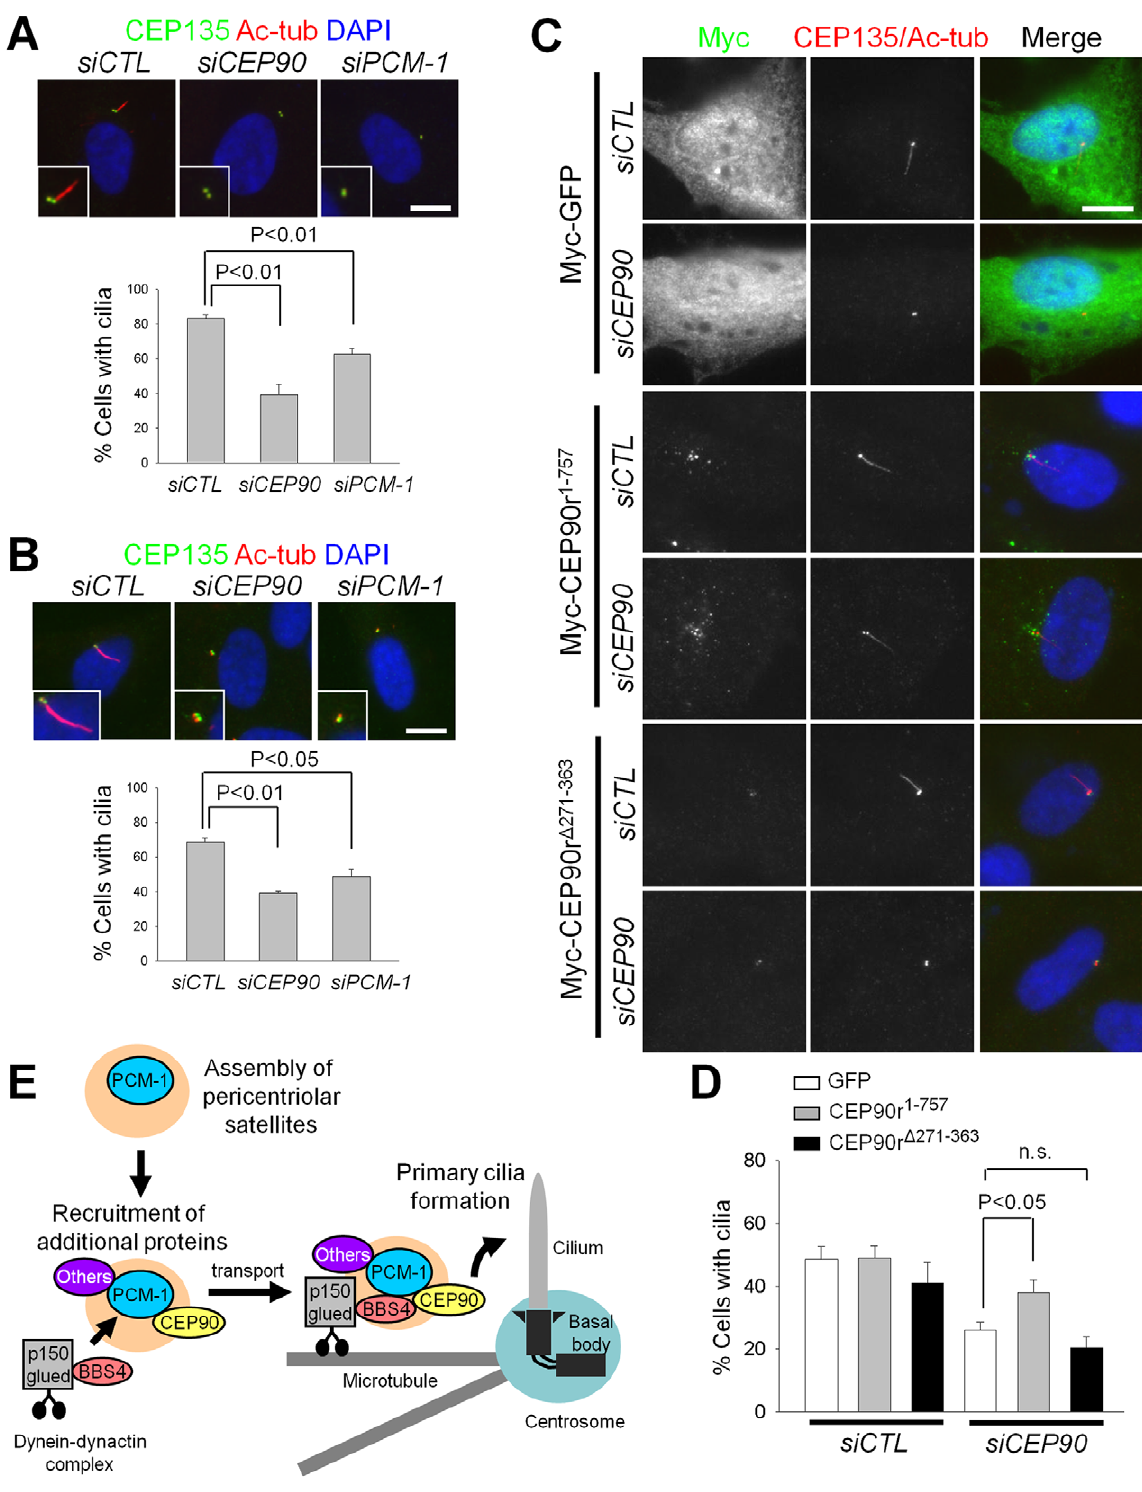
Figure 5. CEP90 is required for primary cilia formation. (A) The CEP90- and PCM-1-depleted RPE-1 cells were cultured in serum-starved medium. The cells were co-immunostained with antibodies specific to CEP135 and acetylated-tubulin. The number of cells with primary cilia ( $ 1 m m in length) was counted. Over 300 cells were analyzed in 3 independent experiments. (B) The CEP90- and PCM-1-depleted RPE-1 cells were treated with cytochalasin D (100 nM) in serum-starved medium for 16 h. The number of cells with cilia was counted. Over 300 cells were analyzed in 3 independent experiments. (C–D) The CEP90-depleted RPE-1 cells were rescued with RNAi-resistant Myc-CEP90 (Myc-CEP90r 1–757 and Myc-CEP90r D 271– 363 ). The cells were treated with cytochalasin D (100 nM) in serum-starved medium for 16 h. (C) Basal bodies and cilia were immunostained together with antibodies specific to CEP135 and acetylated-tubulin, respectively. (D) The number of cells with cilia was counted. Over 300 cells were analyzed in 6 independent experiments. The graphs show mean values and standard errors (A, B, D). (E) A model: CEP90 for centrosomal localization of